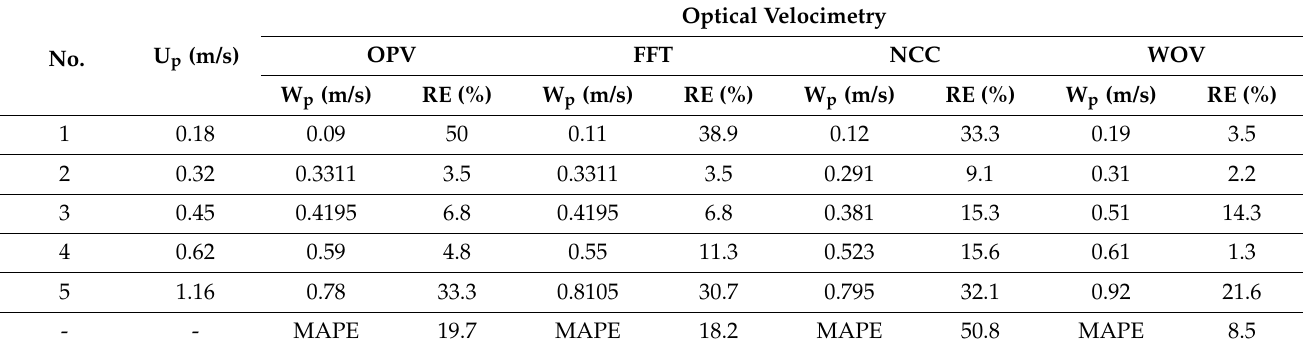
Table 1. Comparison between the optical velocimetries (OPV, FFT, NCC, WOV).